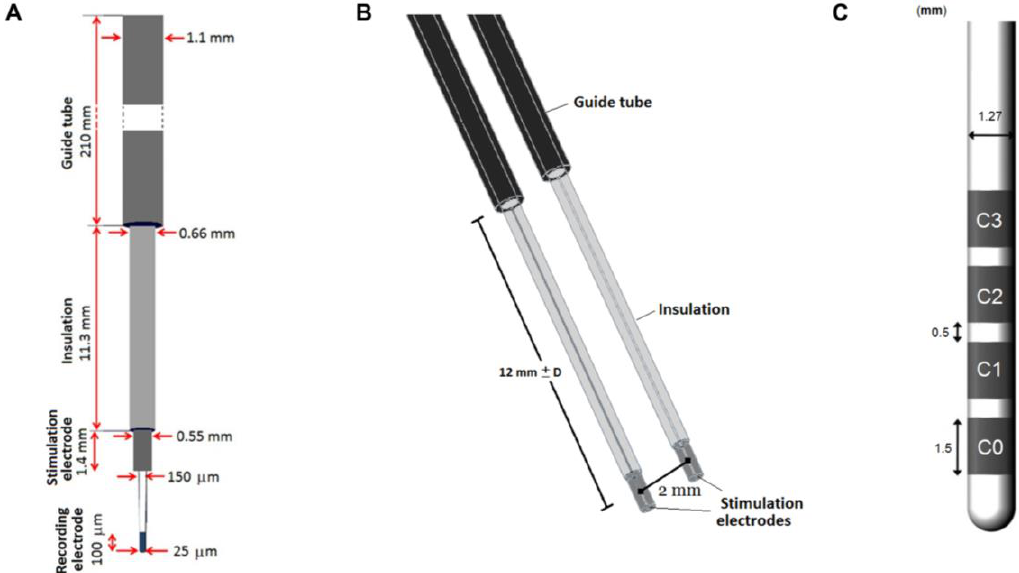
Figure 1. Schematic representation of the microelectrode recording (MER) system and DBS. ( A ) The intraoperative MER lead, including the guide tube and recording electrode. ( B ) 3D model including a parallel lead in the posterior trajectory along the preoperative planned trajectory and ( C ) DBS lead 3389 model.